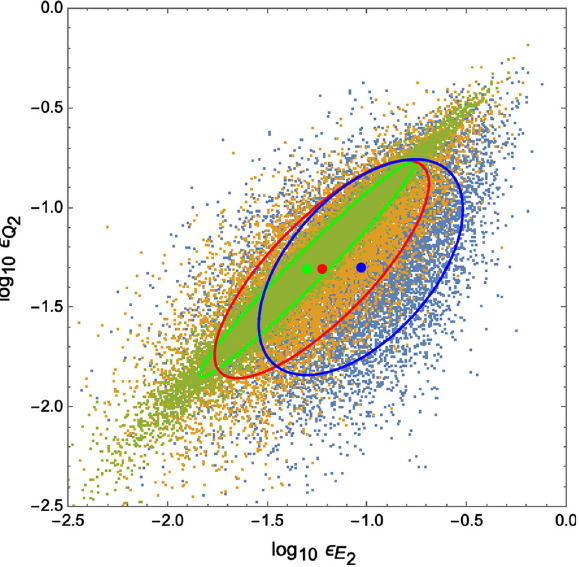
Fig. 1 Second-generation eigenvalues of E E c and E Q for N (cid:4) = 5, a (cid:4) = 0 . 6 and b (cid:4) = 0 . 05 (green), b (cid:4) = 0 . 2 (orange) and b (cid:4) = 0 . 4 (blue). We use uniform priors for the complex entries of A (cid:4) The mean values and one-sigma contours are also shown in each case. One can see that the degeneracy appearing at b (cid:4) = 0 is progressively removed for larger b (cid:4) (the correlation coefficients are 0 . 97, 0 . 78, and 0 . 53 respectively). Notice that the mean values for E E c shift much more because of its larger hypercharge